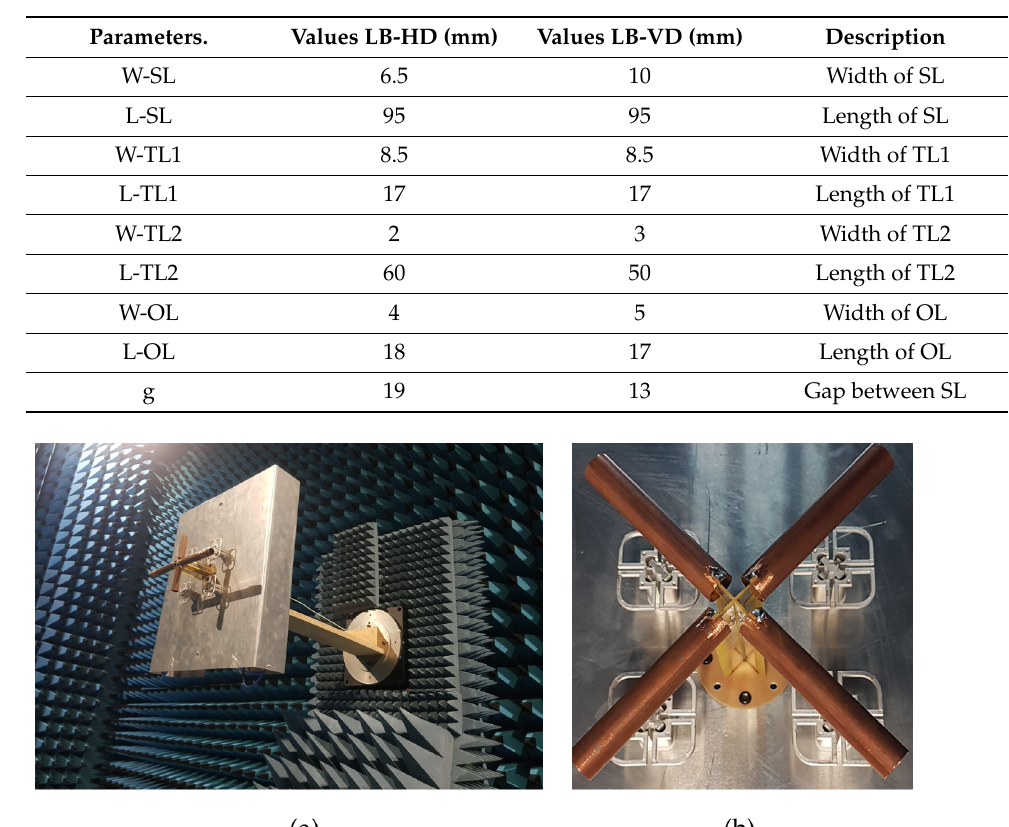
Figure 9. Fabricated prototype with ( a ) LBHV antenna element ( b ) LB slant element.